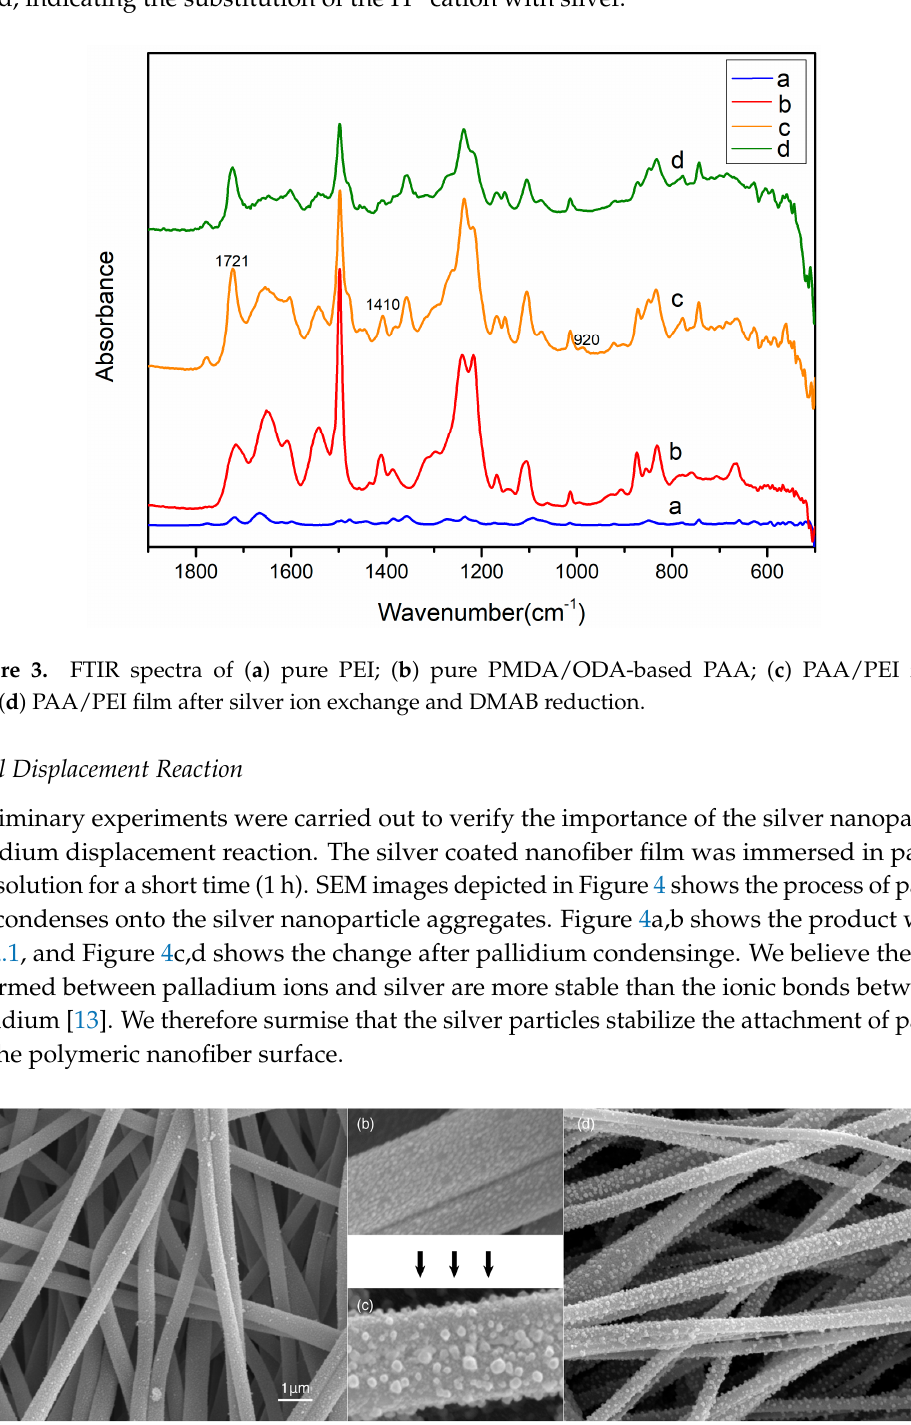
Figure 4. SEM image of nanofibers before and after immersion in 0.5 g/L PdCl 2 aq. for 1 h. ( a , b ) Polyimide nanofibers with silver nanoparticle; ( c , d ) the appearance change after PdCl 2 aq. Treating.